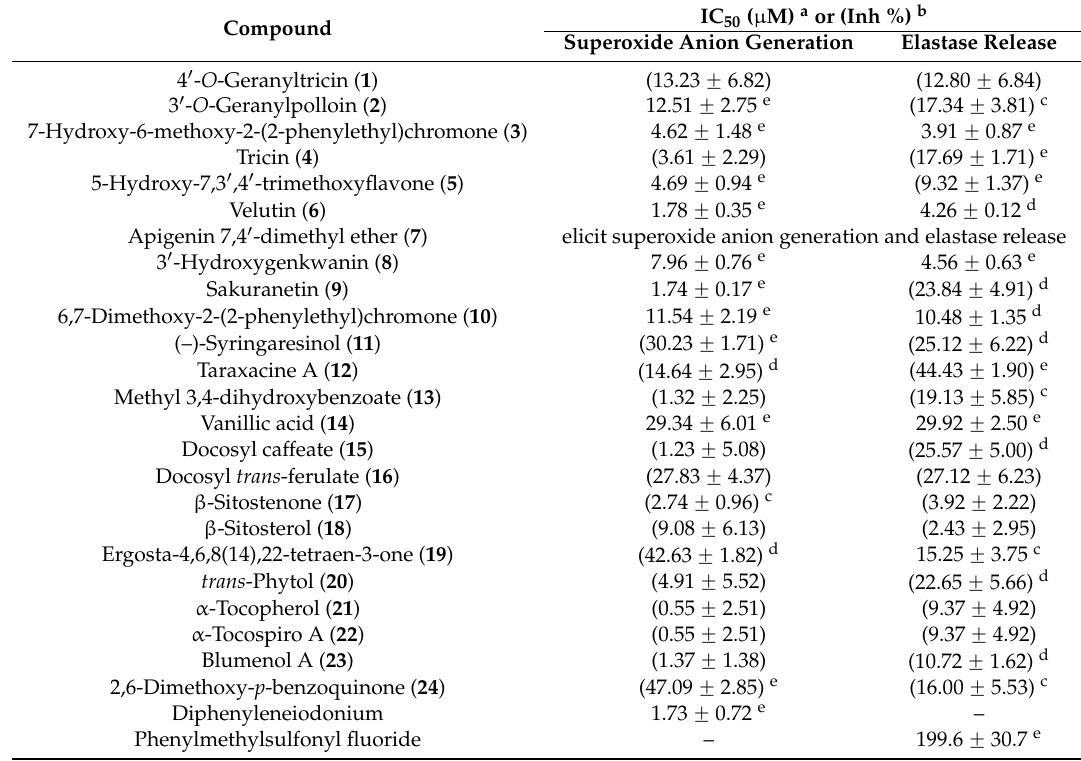
Table 1. Inhibitory effects of compounds 1 – 24 from the stem barks of A. sinensis on superoxide radical anion generation and elastase release by human neutrophils in response to fMet-Leu-Phe/ cytochalasin